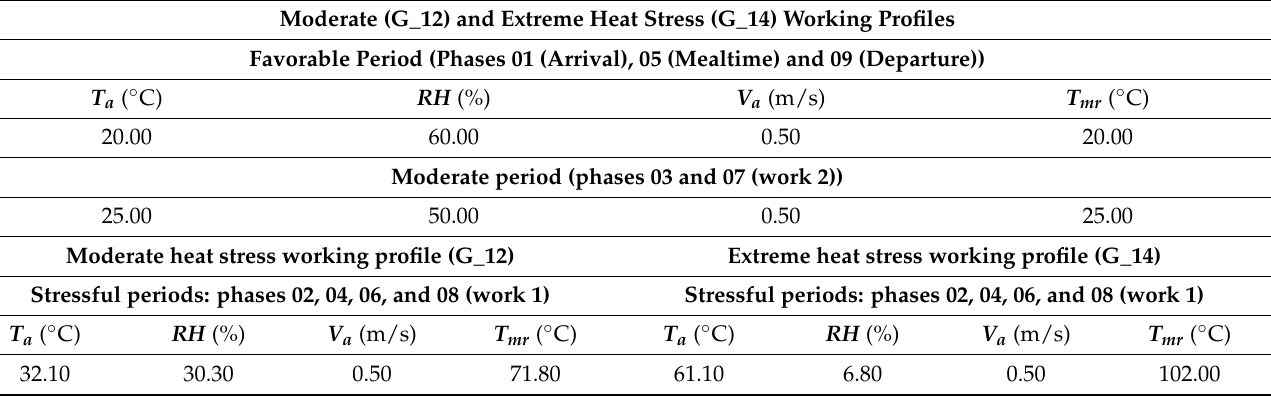
Table 2. Global characteristics of the surrounding environment for working profiles G_12 and